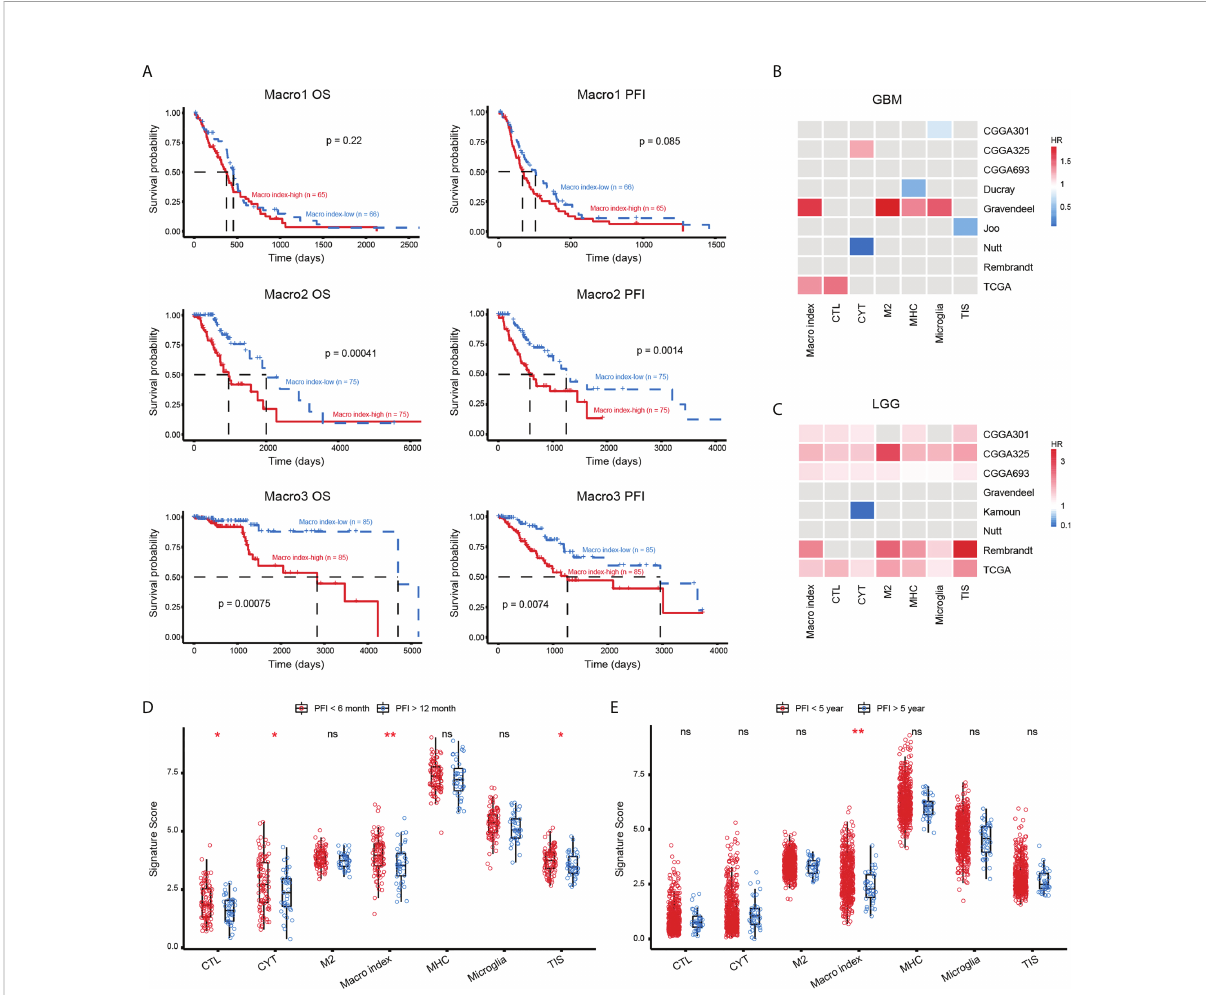
FIGURE 6 The prognostic signi fi cance of Macro index-based groups. (A) The differences in OS and PFI between the Macro index-high and -low groups based on the TCGA cohort. ( B , C ) The prognostic signi fi cance of the Macro index as well as other immune-related gene signatures in GBM and LGG of multiple cohorts. The Gray box represents statistically insigni fi cant. CTL, cytolytic T lymphocyte; CYT, cytolytic activity; MHC, major histocompatibility complex; TIS, T cell in fl ammation signature. (D) Comparison of the scores of immune gene signatures in GBM patients that were early relapsed (PFI < 6 months) and late relapsed (PFI > 12 months). (E) Comparison of the scores of immune gene signatures in LGG patients that were early relapsed (PFI < 5 years) and late relapsed (PFI > 5 years). *p < 0.05, **p < 0.01, ns, non signi fi